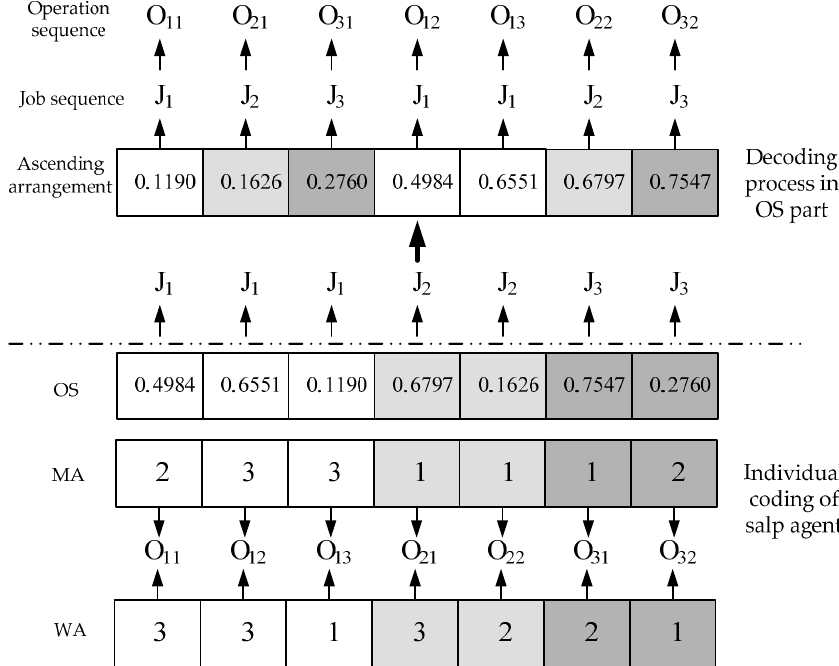
Figure 2. Individual coding and OS part decoding process of the salp agent.